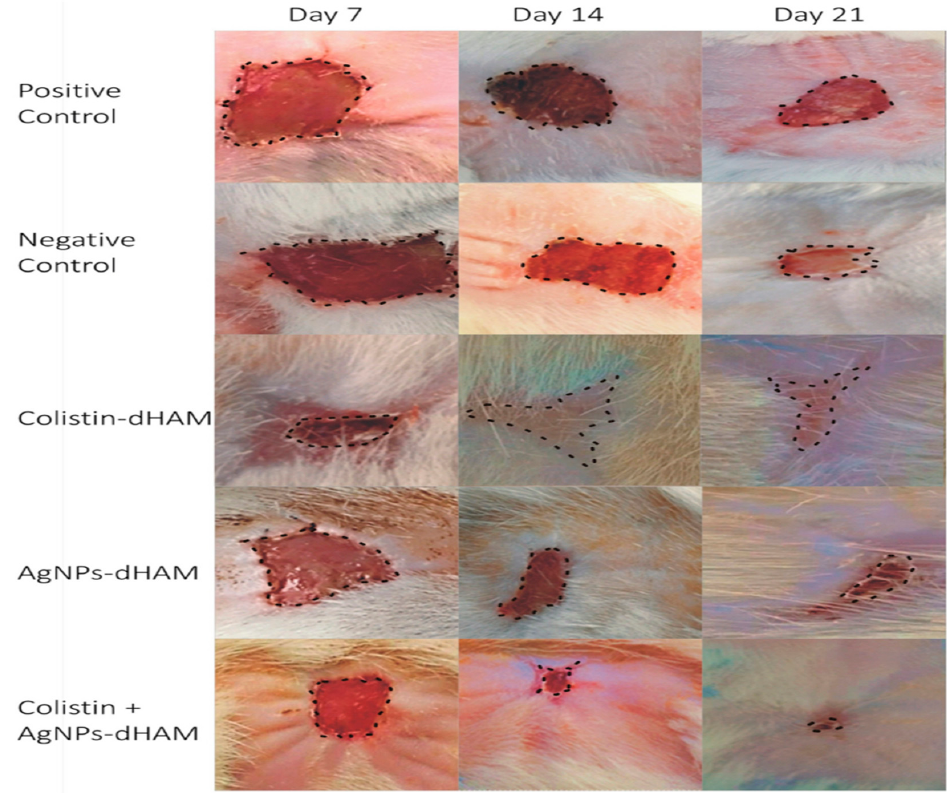
Figure 7. Wound healing evaluation against Pseudomonas aeruginosa in burn wound infected rat model at different time points using different wound dressings. The wound dressings employed for healing assessment comprises decellularized human amniotic membrane (dHAM) containing colistin and/or silver nanoparticles (AgNPs). Reproduced from the ref. [328] with permission from Na-